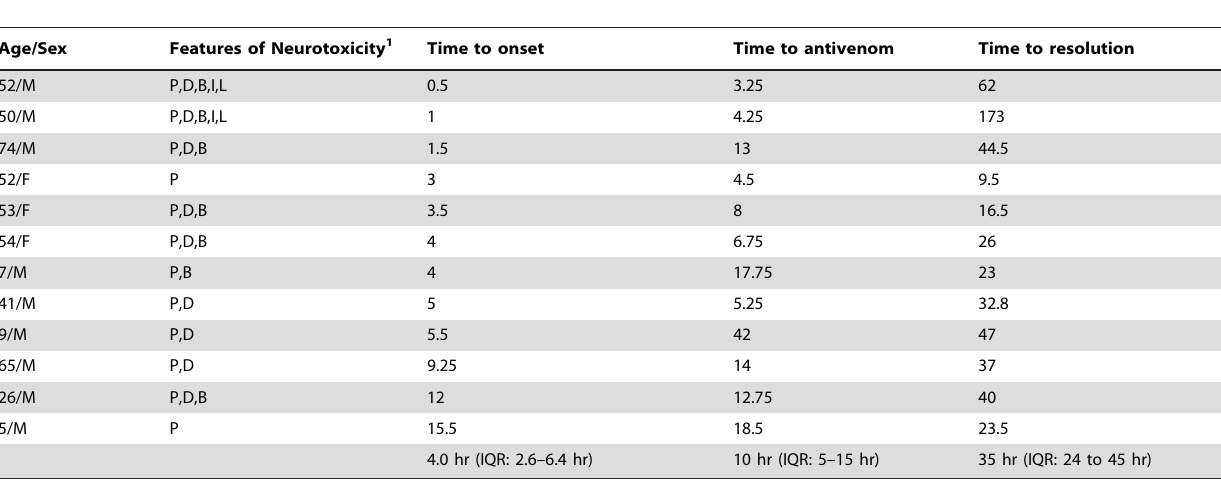
Table 3. Summary of patients with neurotoxicity including the time of onset and resolution and the time of antivenom.